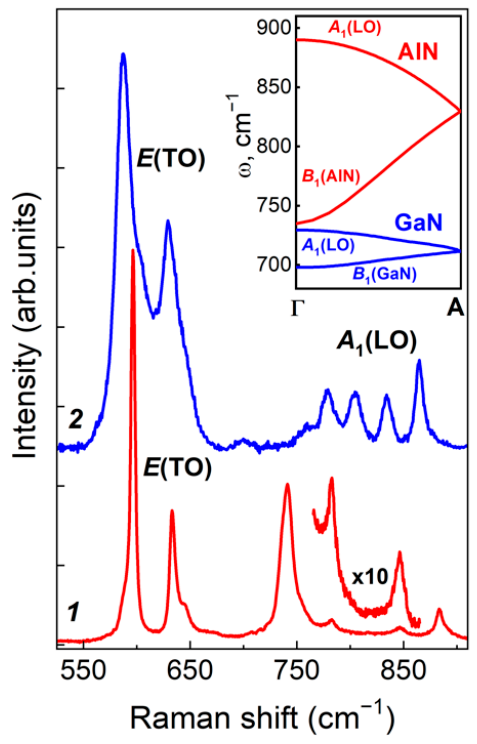
Figure 1. Experimental 𝑧(𝑥𝑥)𝑧̅ Raman spectra of the (GaN) 6 /(AlN) 6 SLs in the range of E (TO) and A 1 (LO) modes. The SLs were grown by PA MBE ( 1 ) and MOVPE ( 2 ). The inset shows the dispersion range of A 1 (LO) and B 1 (high) phonons of bulk AlN and GaN along the Г —A direction of the BZ [38,39].